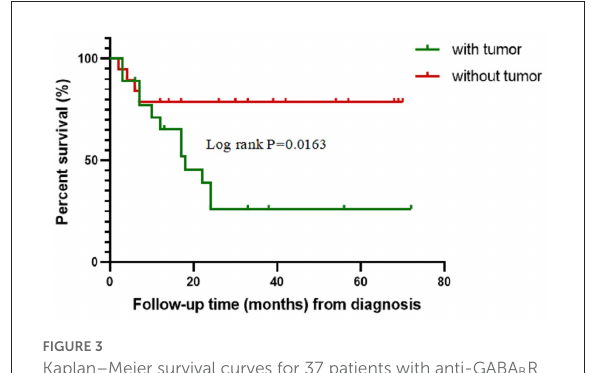
FIGURE3 Kaplan–Meier survival curves for 37 patients with anti-GABA B R